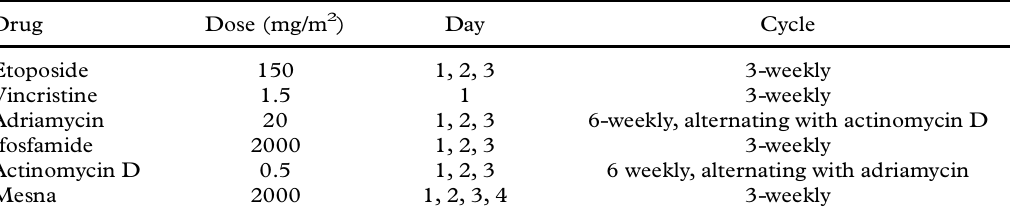
Table 1. EVAIA chemotherapy for high-risk patients as per EICESS 92 protocol